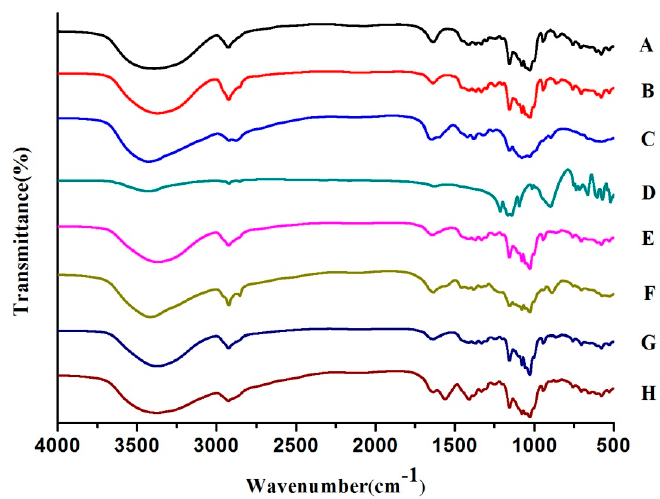
Figure 3. Fourier transform–infrared (FT-IR) spectra of different materials. A: β -CD; B: GEO/ β -CD composite; C: Chitosan; D: sodium tripolyphosphate (STPP); E: Physical mixture (with STPP); F: GEO/ β -CD/CTS particles; G: Physical mixture (without STPP); H: GEO/ β -CD/CTS microsphere. The photograph shown in H represented the infrared spectrum of GEO/ β -CD/CTS microsphere.